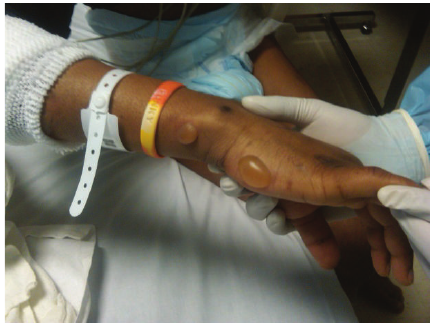
Figure 1: Tense serous fluid filled bullae.